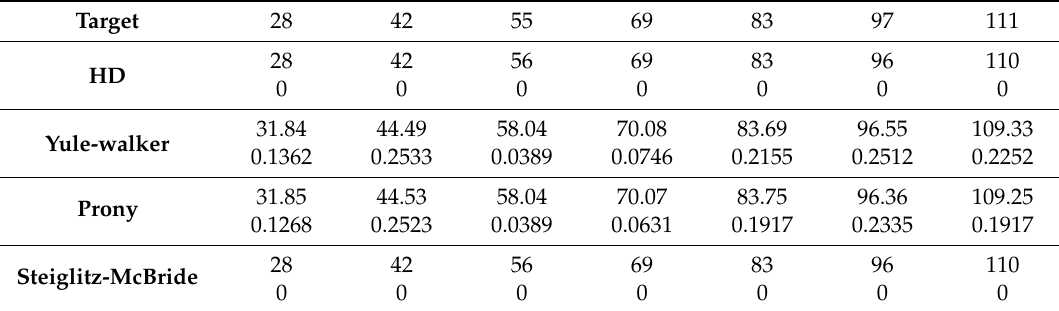
Table 4. Experiment results as mean (upper row) and variance (lower row) for 100 ensemble length.